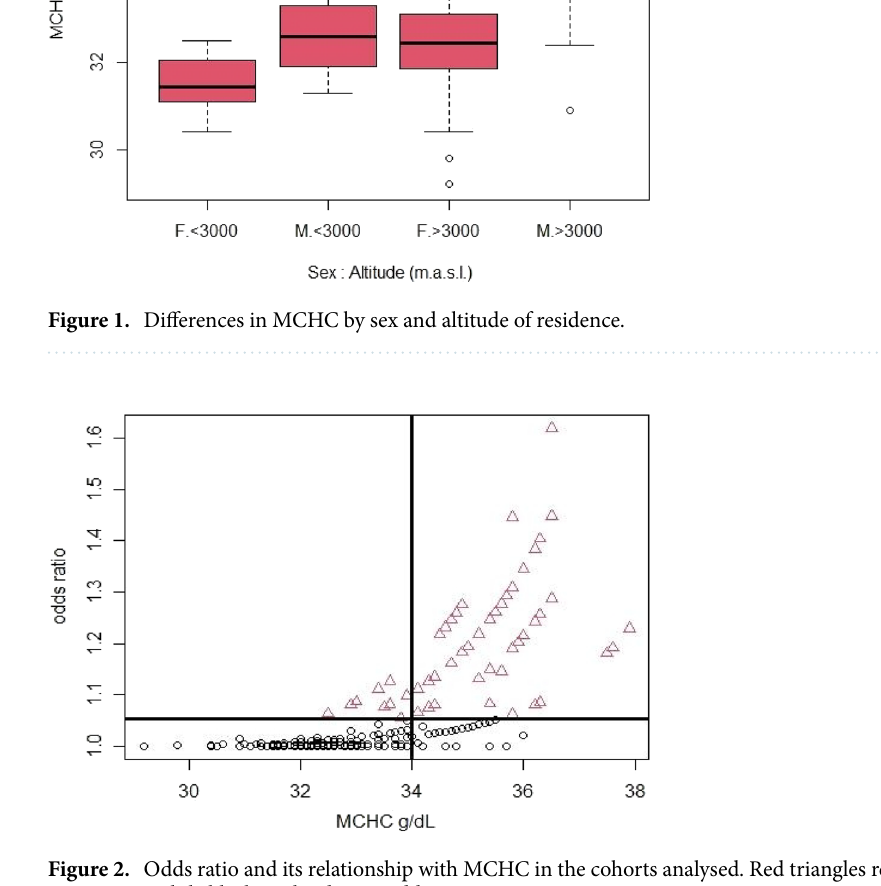
Figure 2. Odds ratio and its relationship with MCHC in the cohorts analysed. Red triangles represent odds ratio ≥ 1.05, while black circles denote odds ratio <